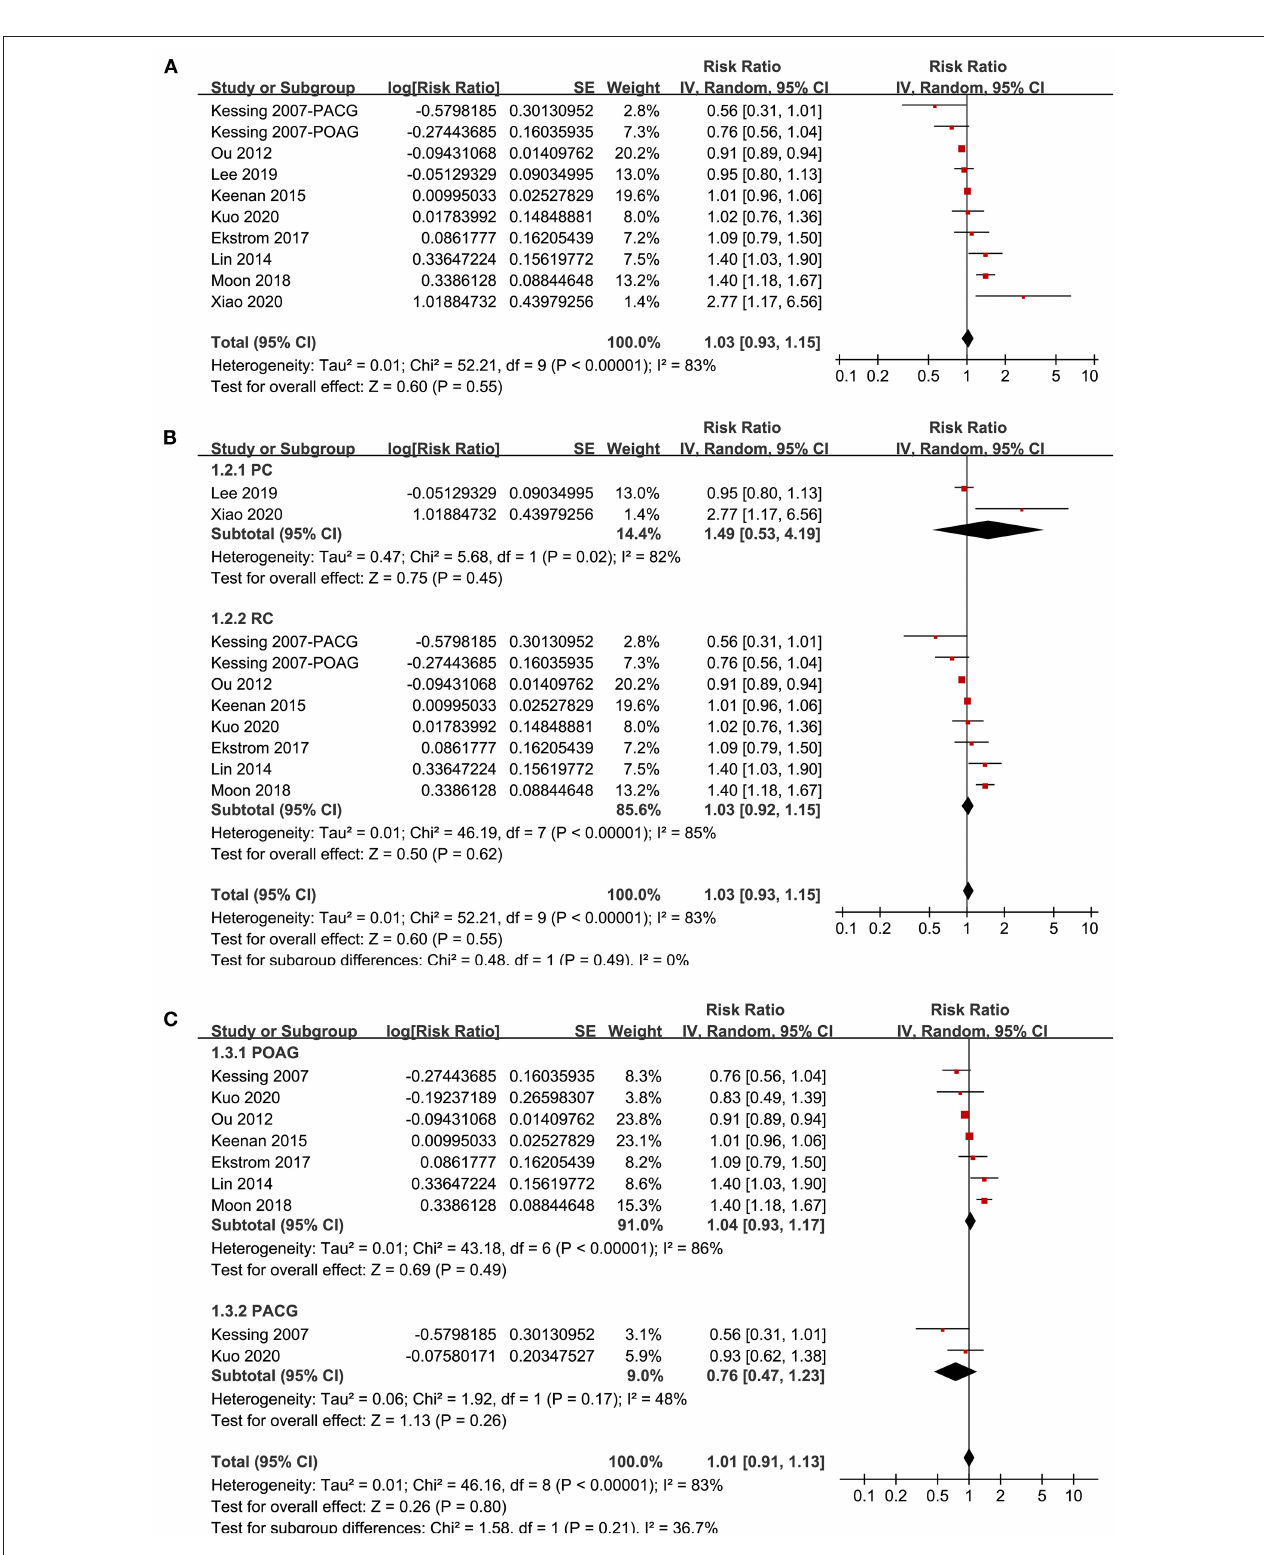
FIGURE 2 | Forest plots for the meta-analysis of the association between glaucoma and the incidence of AD in adult population; (A) overall meta-analysis; (B) subgroup analysis according to the study design; and (C) subgroup analysis according to the type of glaucoma.